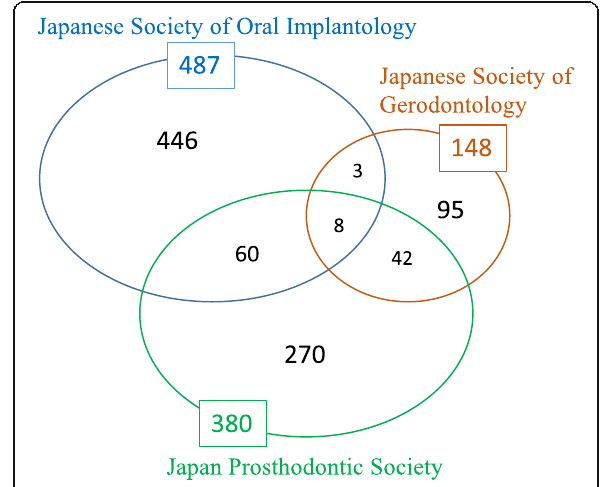
Fig. 1 Breakdown of respondents. The retrieval rate was approximately 40% in each of the three societies